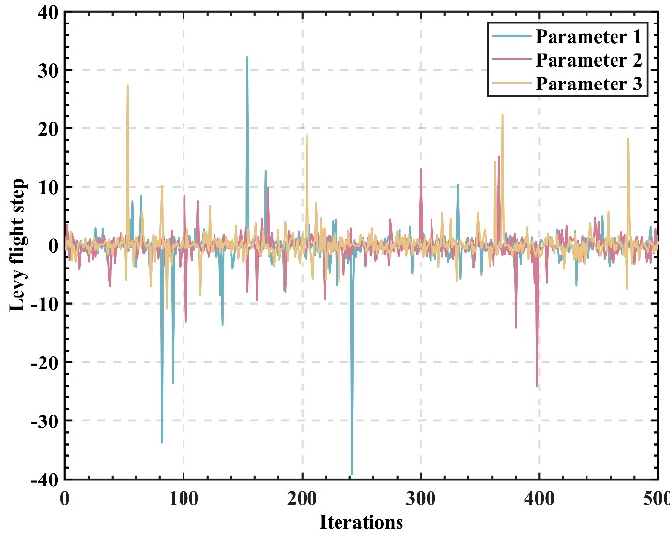
Figure 4. Lévy flight iterations. Figure 4. L é vy flight